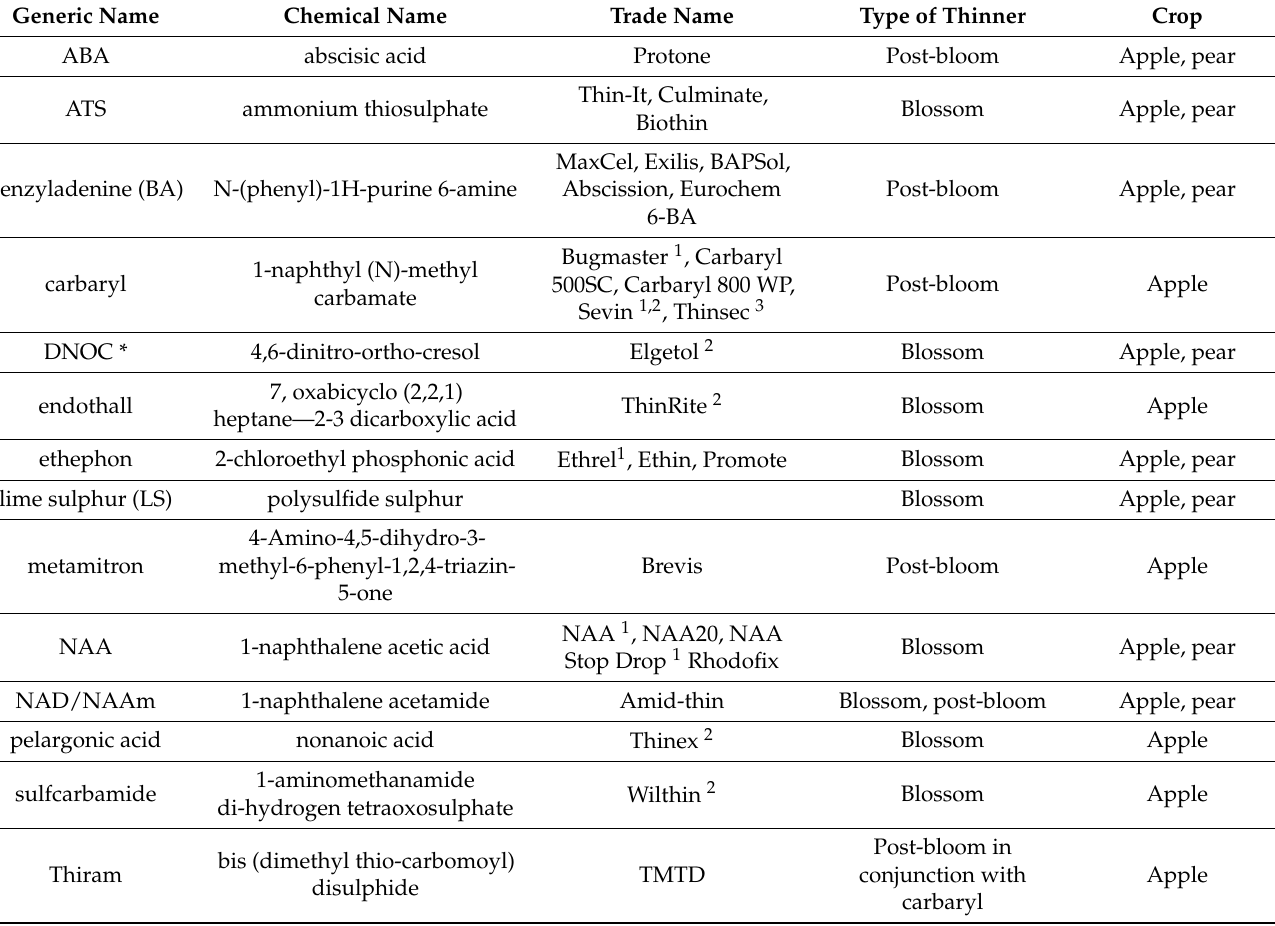
Table 1. Chemicals used worldwide for thinning of pome fruit (apple and